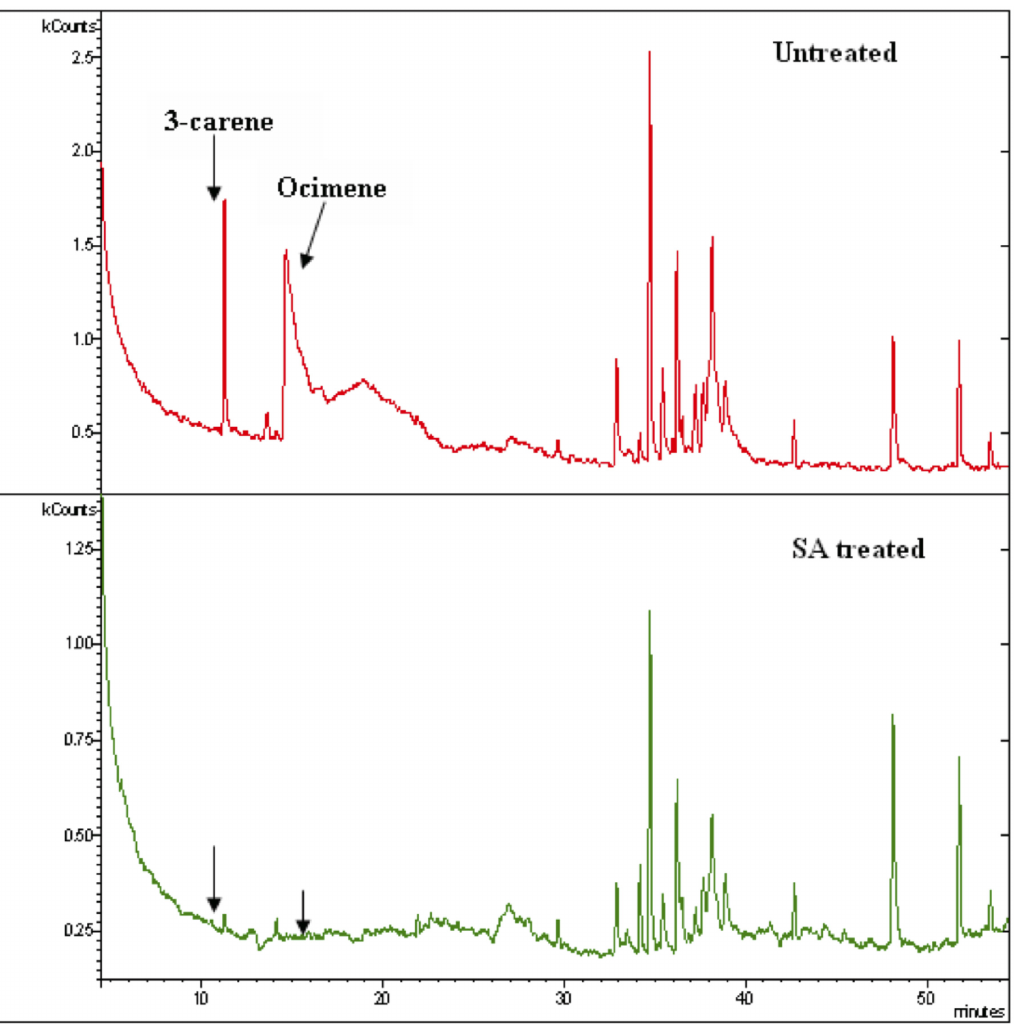
Fig 5. GCMS chromatogram of untreated and SA treated Totapuri fruit volatiles. The chromatogram showing differential expression of 3-carene and cis-